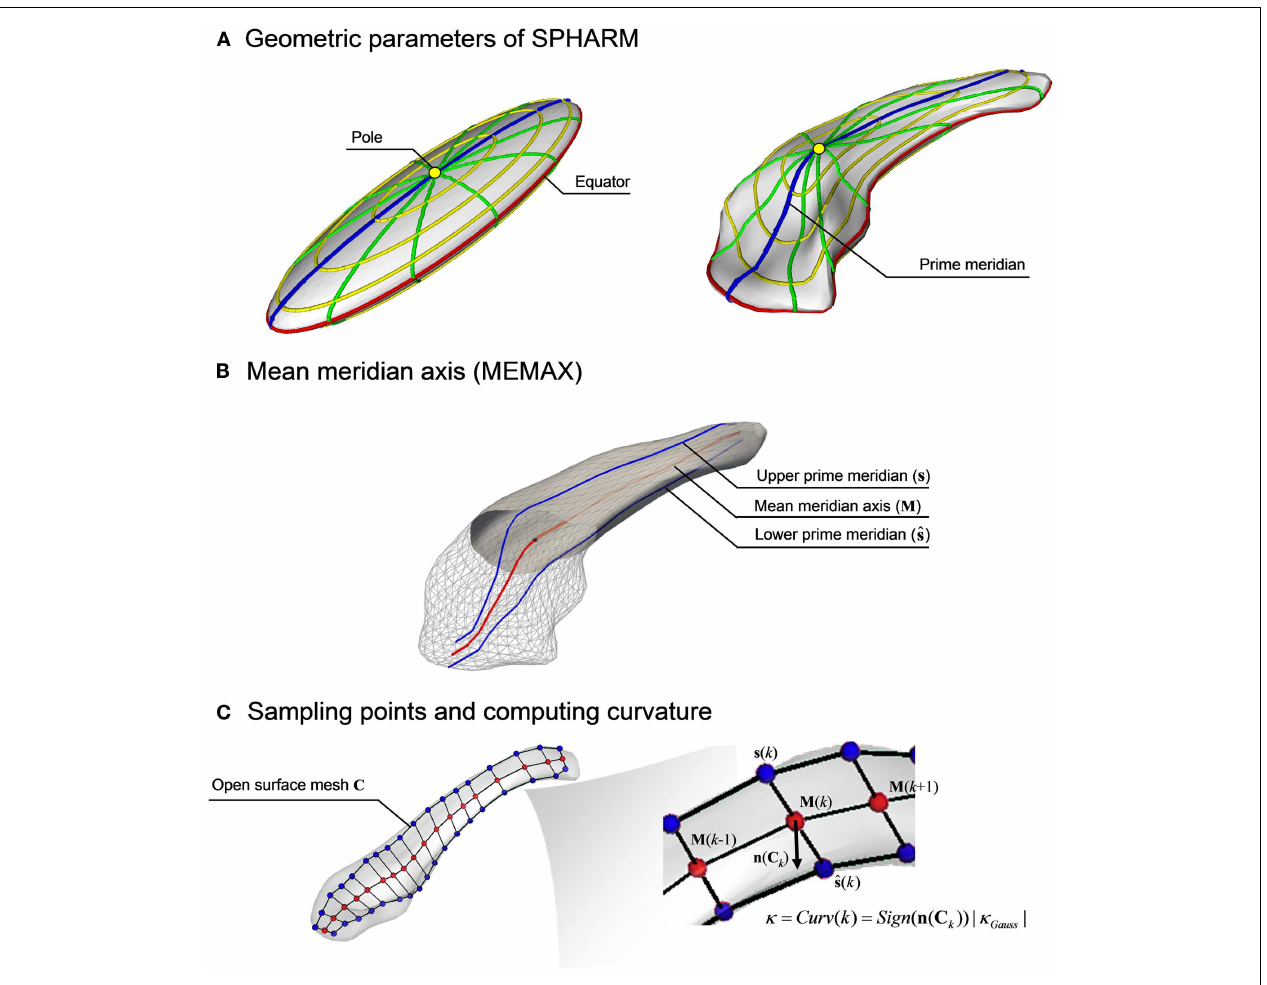
geometric mean of the upper ( s ) and lower ( ˆs ) prime meridians generates the mean meridian axis (MEMAX, M ). (C) Using an equidistant subdivision of the latitudes, K points are sampled on M . After creating an open surface mesh (C) , whose boundaries are defined by the prime meridians s and ˆs, the signed Gaussian curvature ( κ Gauss ) is computed at each sample point M ( k ) through the surface normal vector n ( C k